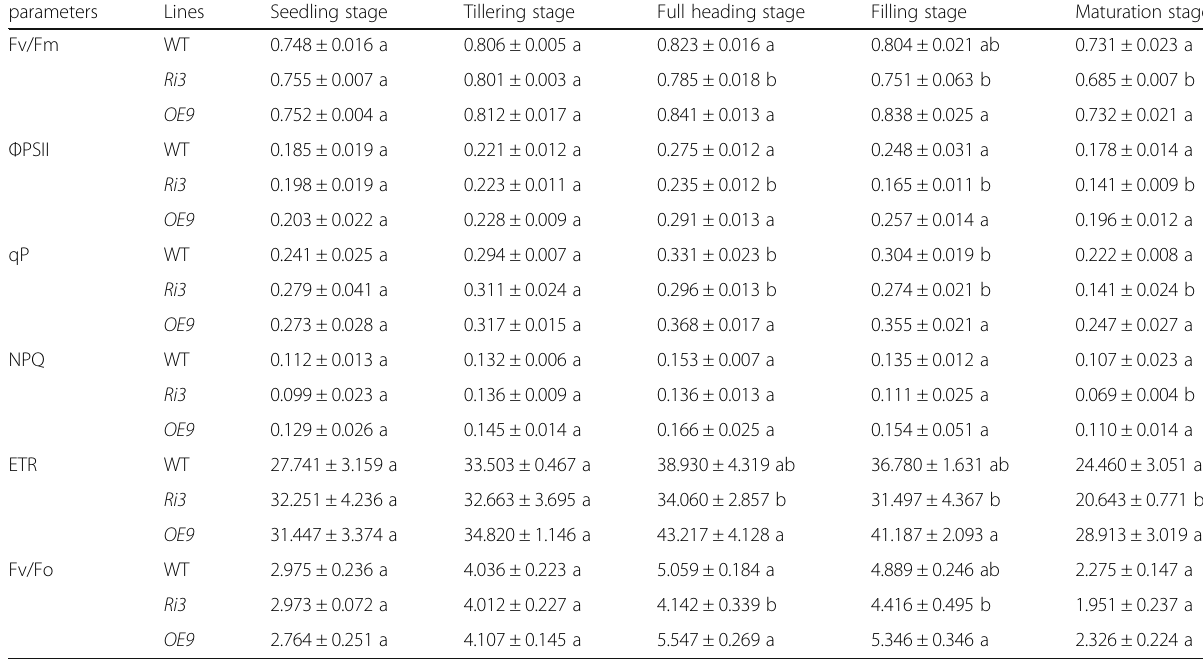
Table 1 Chlorophyll fluorescence kinetic parameters in wild-type and transgenic lines at different growth stages parameters